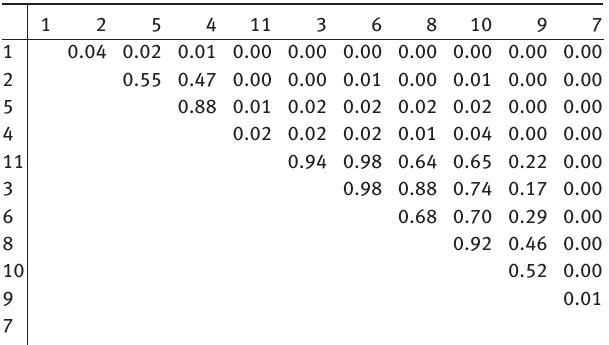
Table 7: The p -values for pairwise conditional